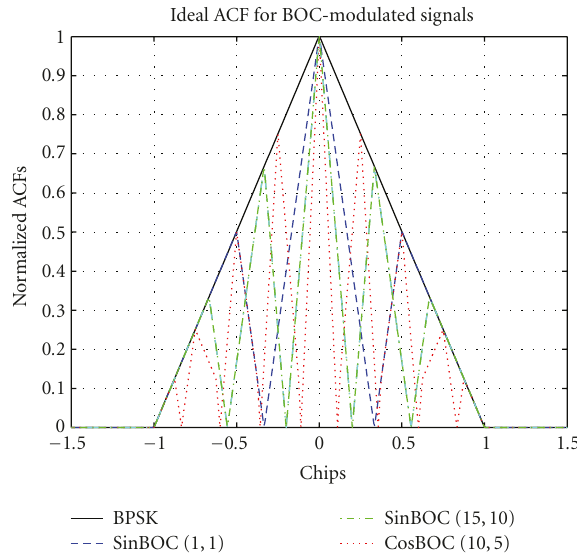
Figure 3: Examples of absolute value of the ACF for BOC- modulated